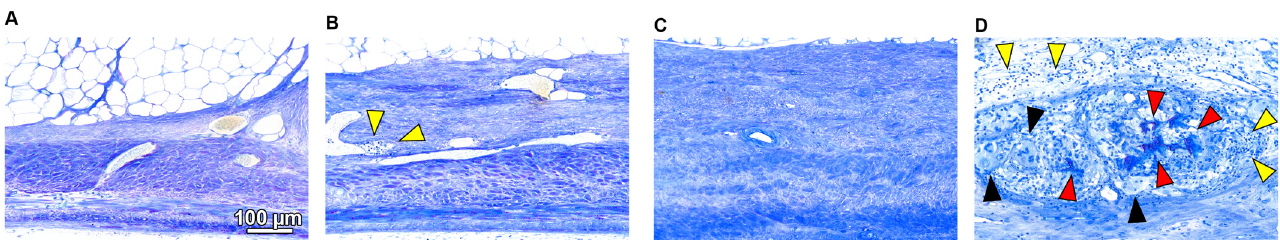
Figure 6. The magnified views of toluidine blue and fuchsin staining in the middle area at high magnification (500 × ) in ( A ) Control (empty), ( B ) Ncl_CM, and ( C , D ) Cl_CM groups at three months post-surgery. The yellow arrowheads show lymphocytes, red arrowheads indicate residual materials, and black arrowheads show multinucleated giant cells (MNGCs).